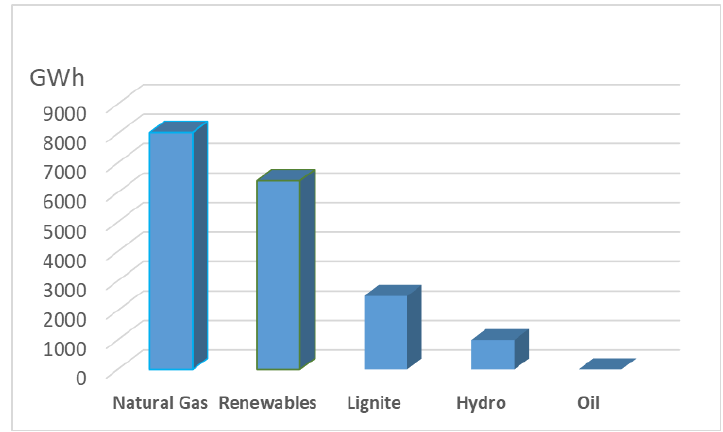
Figure 1. Statistics and facts about energy production in